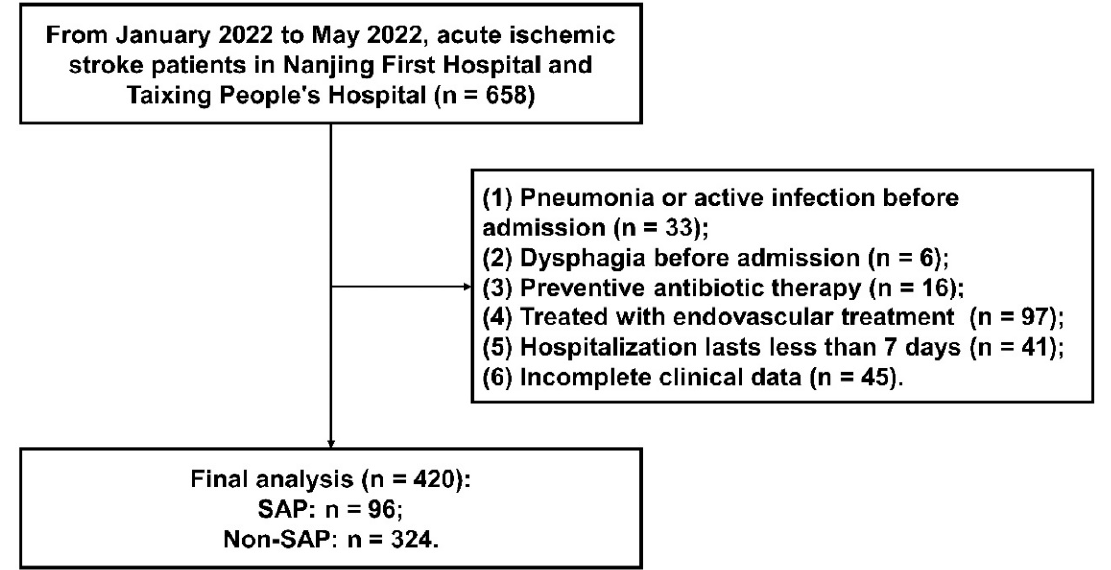
Figure 1. The flowchart of participant